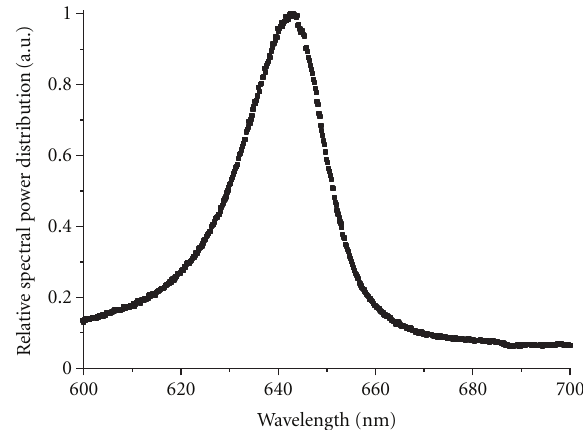
Figure 2: The normalized spectral emission of the LED